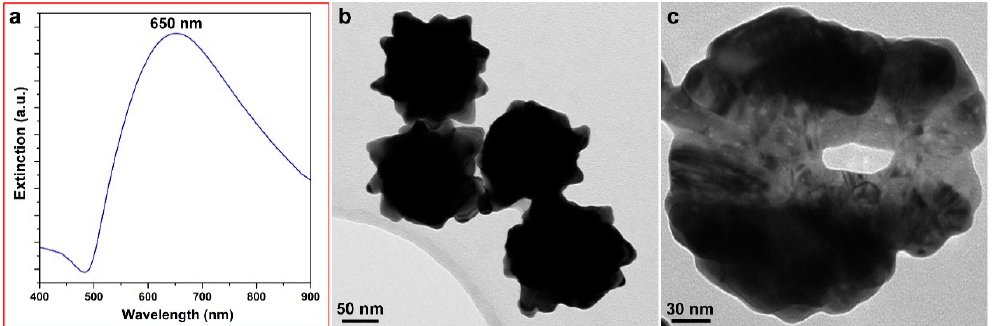
Figure 1. ( a ) UV-vis spectrum of hollow-channel gold nanoflowers (HAuNFs) synthesized with ascorbic acid (AA). ( b ) TEM image showing multiple branches on the outer surface; ( c ) TEM image in an orientation showing the hollow channel in the center.